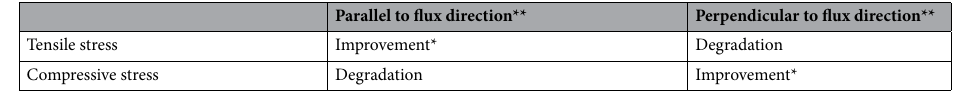
Table 4. Effect of mechanical stress applied in the plane of electrical steel sheet on its magnetic properties 1,17 . *Up to a few tens of MPa, then a degradation is observed with higher stress levels. **For an identical level of stress, stresses along the magnetic flux direction are quantitavely more impactful than those perpendicular 1 .